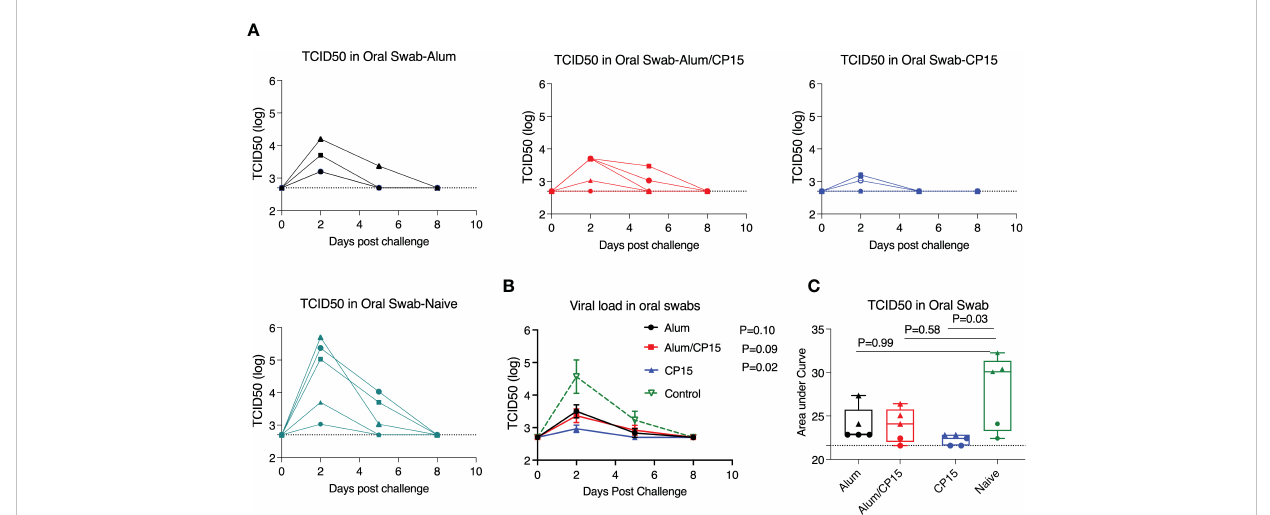
FIGURE 2 The CP15 group showed signi fi cant oral swab viral load reduction after challenge with SARS-Cov-2 WA strain in Syrian golden hamsters. After challenge with SARS-CoV-2 WA strain, oral swabs from each hamster were collected at different time points and viral loads were measured as TCID50. (A, B) . Oral swab viral loads of each hamster from different groups (A) and the summary (means) of each group (B) are shown. (C) The area under the curve of oral swab viral loads from each group are shown. N=5 for each group, and each symbol represents one animal in (A) . The dots denote female, while the triangles denote male in (C) . Two-way ANOVA and Kruskal-Wallis tests with Dunn ’ s multiple comparison corrections were used to compare between the vaccinated groups and the control group. Dashed line shows the detection limit. Mean ± SEM are